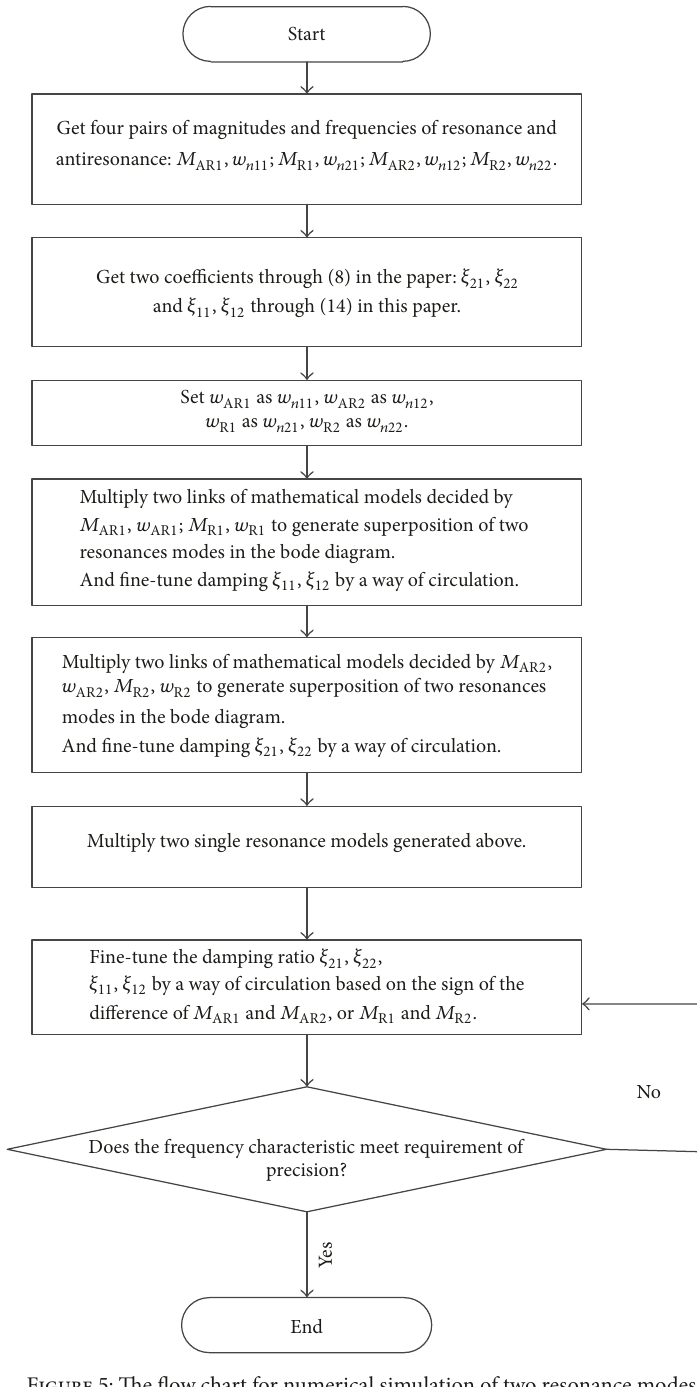
magnitude of 10 dB, while the resonant frequency is 690 Hz and the resonant magnitude is 15 dB. Using the approach in